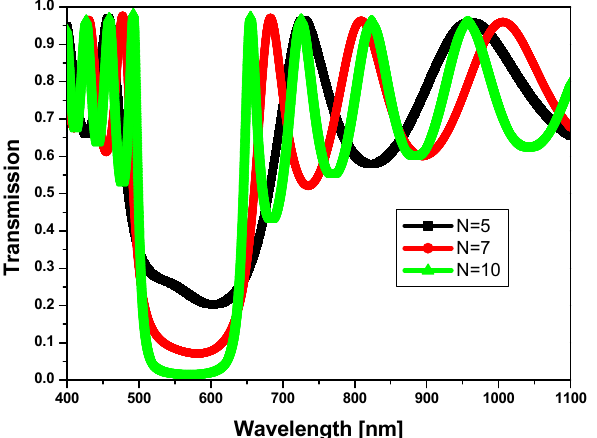
Figure 5. The transmission spectrum of 1D binary photonic crystals of Bi 4 Ge 3 O 12 with thickness d 1 = 62 nm and µ c-SiO x : H with thickness d 2 = 55 nm, with a different number of the period as shown.